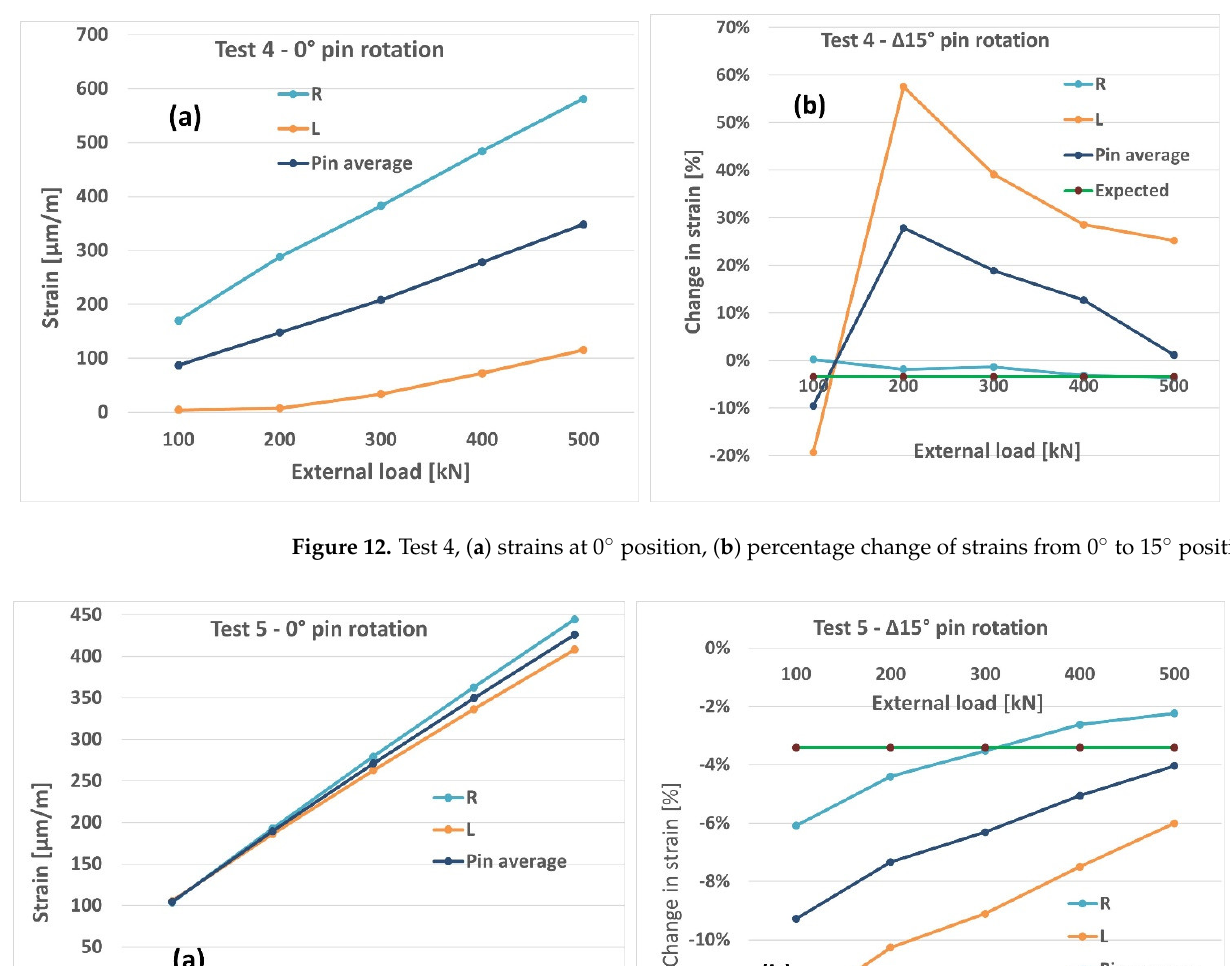
Appl. Mech. 2022 , 3 Figure 11. Test 3, ( a ) strains at 0° position, ( b ) percentage change of strains from 0° to 15° position. Figure 11. Test 3, ( a ) strains at 0 ◦ position, ( b ) percentage change of strains from 0 ◦ to 15 ◦ position.